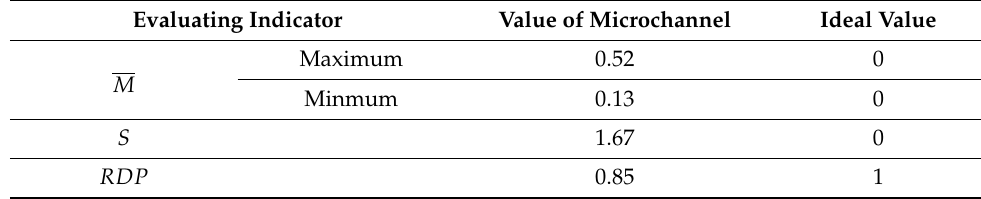
Table 3. Evaluation of the refrigerant distribution uniformity.